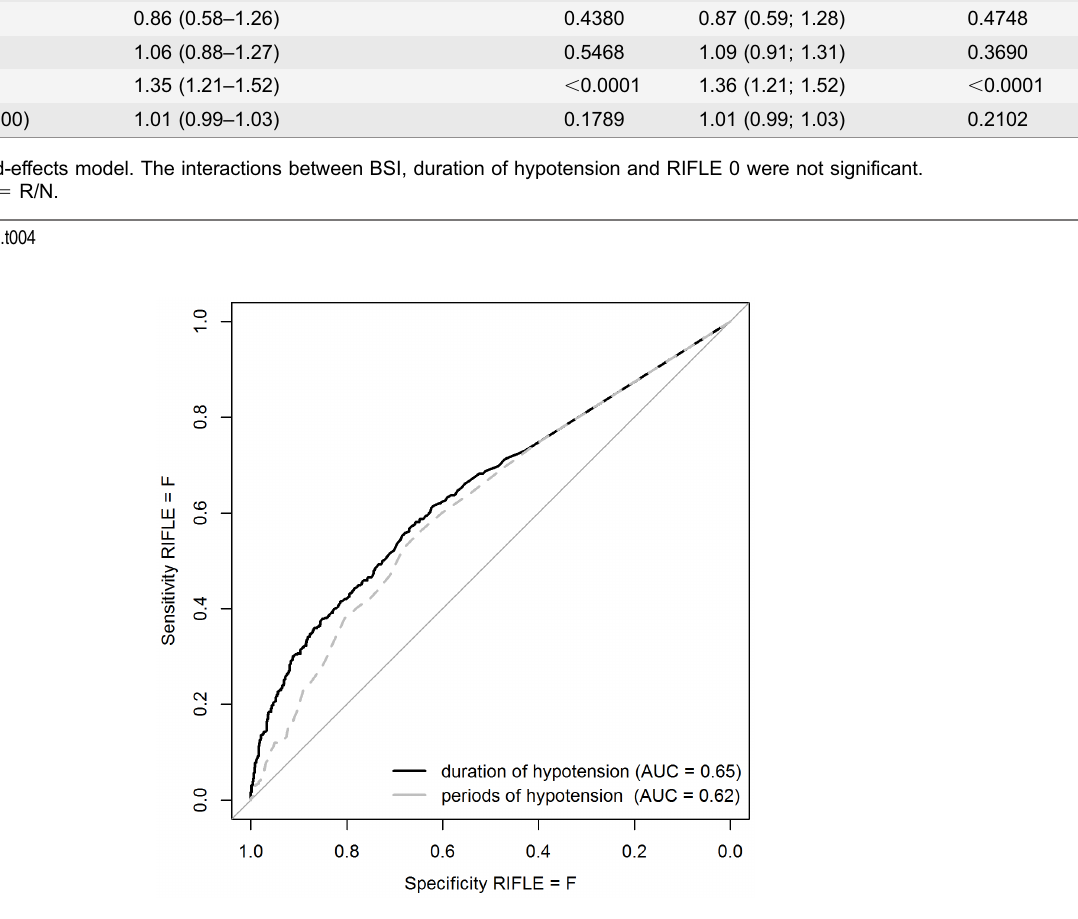
Fig. 1. ROC curve for the detection of RIFLE 5 F based on the duration or number of periods of severe